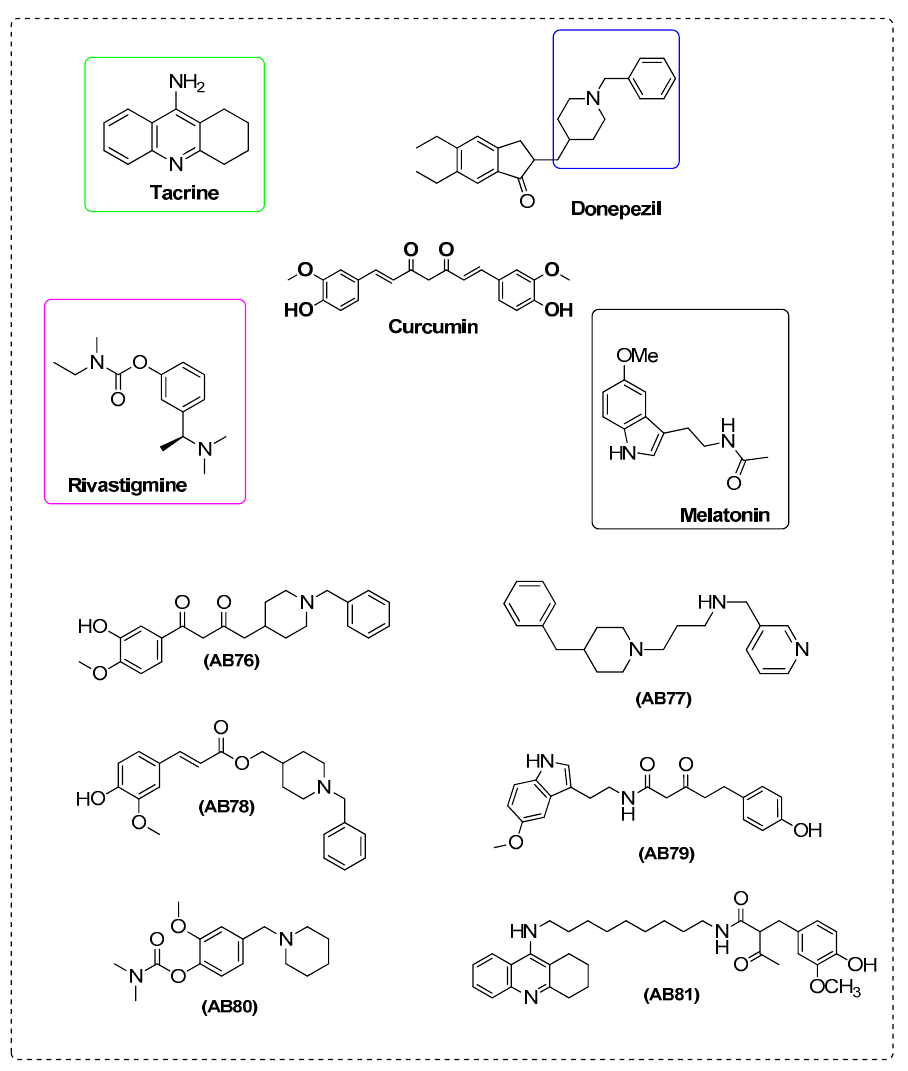
Figure 16. hybrids. Figure 16. Curcumin-based